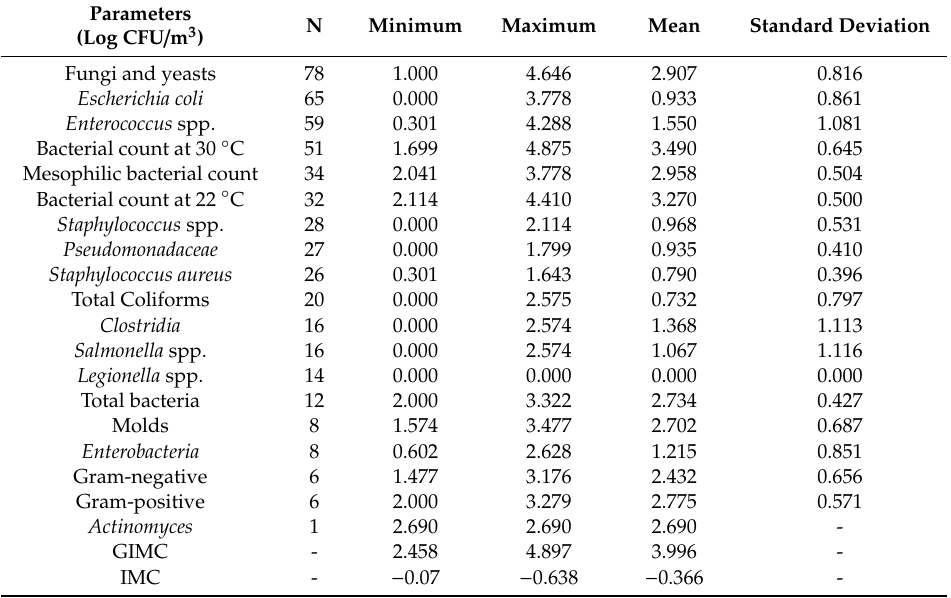
Table 3. Descriptive analysis of occupational bioaerosol monitoring.